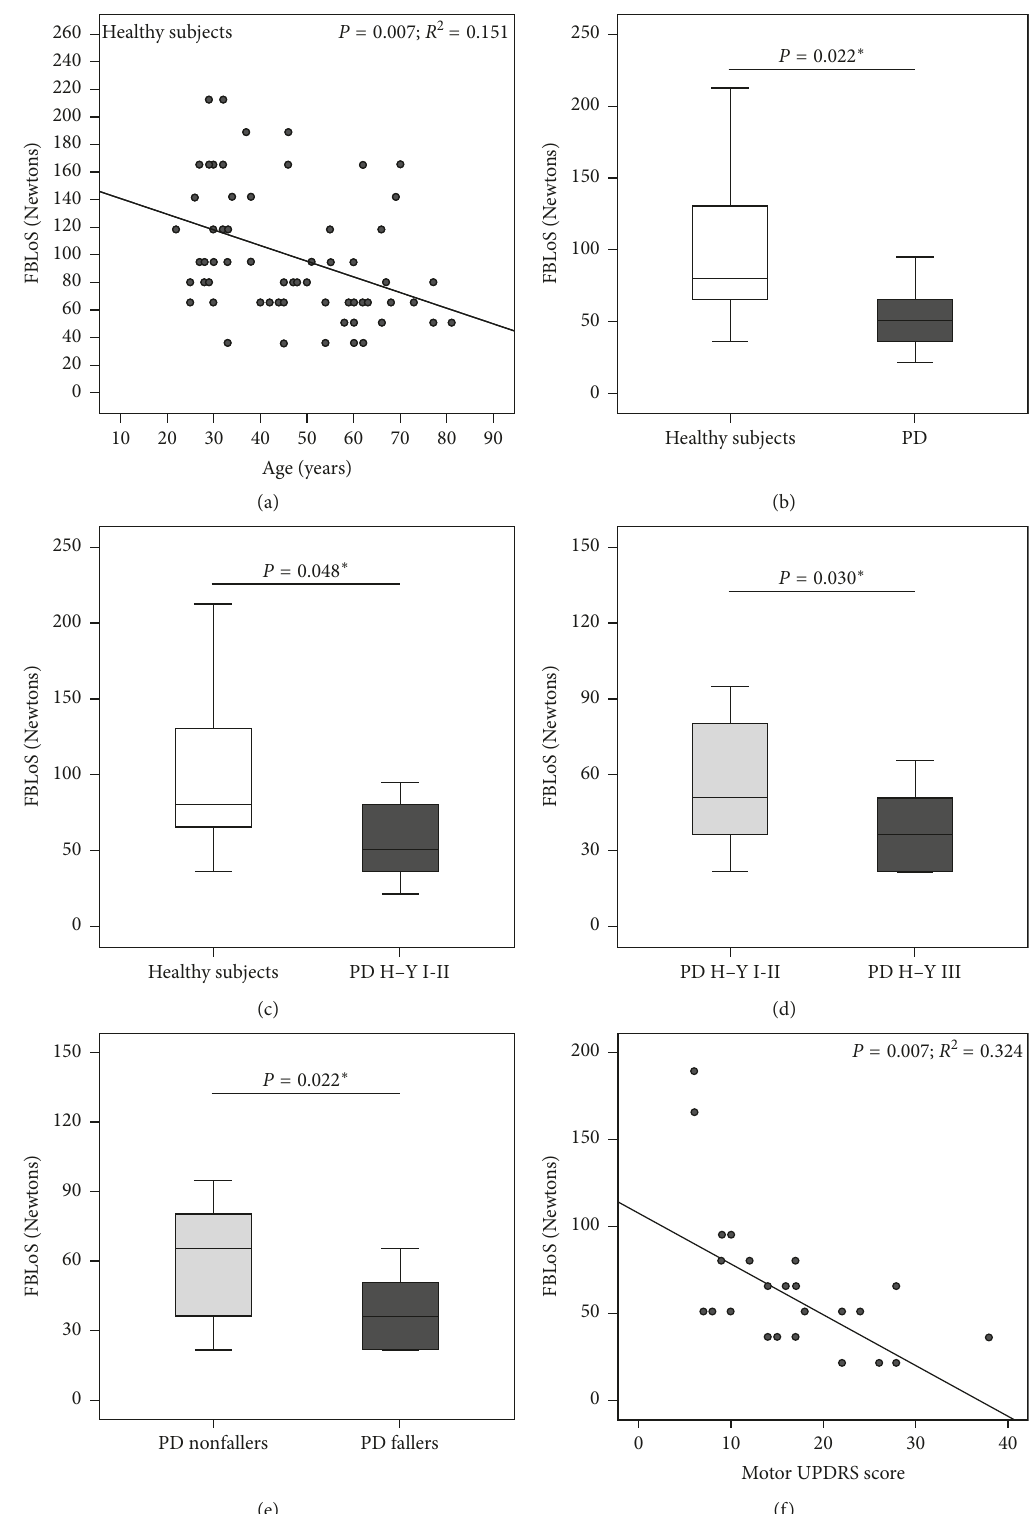
Figure 1: Force to reach the backward limit of stability (FBLoS) in the analyzed groups. PD: Parkinson’s disease patients. H–Y: Hoehn–Yahr. ∗ Adjusted for age and gender. (a) Association between FBLoS and age in healthy subjects. (b) Comparison of FBLoS between healthy subjects and PD patients. (c) Comparison of FBLoS between healthy subjects and PD H–Y stages I-II. (d) Comparison of FBLoS between PD H–Y stages I-II and PD H–Y stage III. (e) Comparison of FBLoS between PD nonfallers and PD fallers. (f) Association between FBLoS and motor UPDRS score in PD